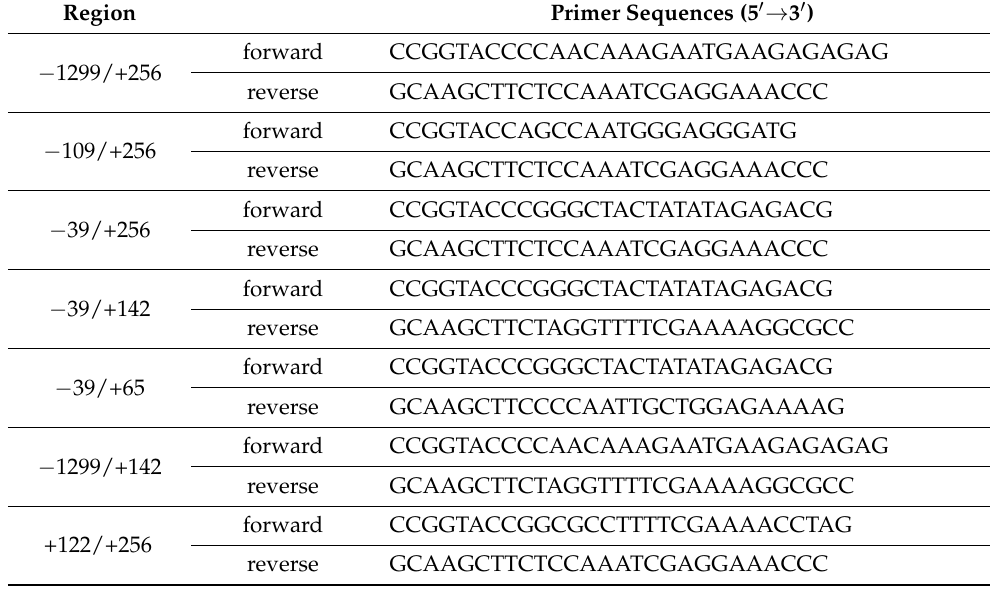
Table A1. Primers used for constructing each TXNIP promoter vector. Region